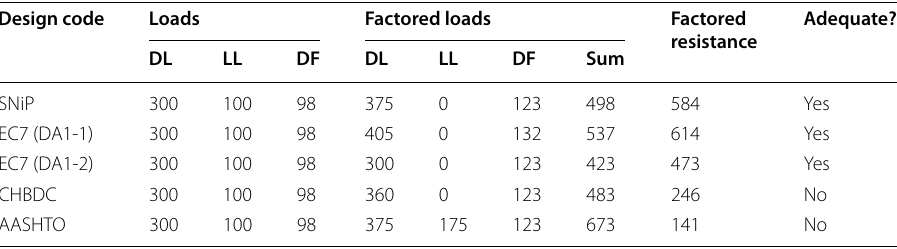
Table 3 Geotechnical ULS calculations according to design codes for Case I Design code